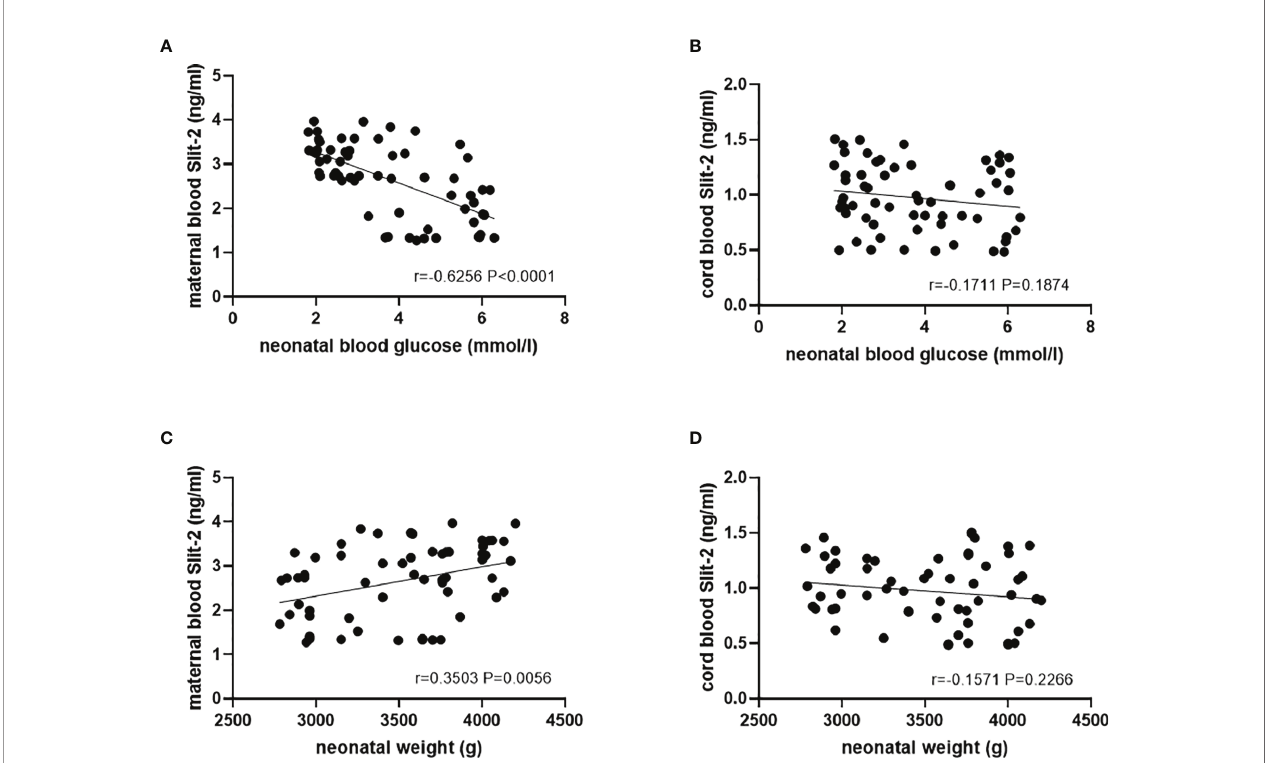
FIGURE 5 | Relationship between the Slit-2 level in maternal peripheral blood and neonatal cord blood and adverse pregnancy outcomes of the patients with GDM. (A) Correlation between the Slit-2 level in maternal peripheral blood and neonatal blood glucose of the patients with GDM. (B) Correlation between the level of Slit-2 in neonatal cord blood and neonatal blood glucose of the patients with GDM. (C) Correlation between the Slit-2 level in maternal peripheral blood and neonatal weight of the patients with GDM. (D) Correlation between the level of Slit-2 in neonatal cord blood and neonatal weight of the patients with GDM. Slit-2, Slit guidance ligand